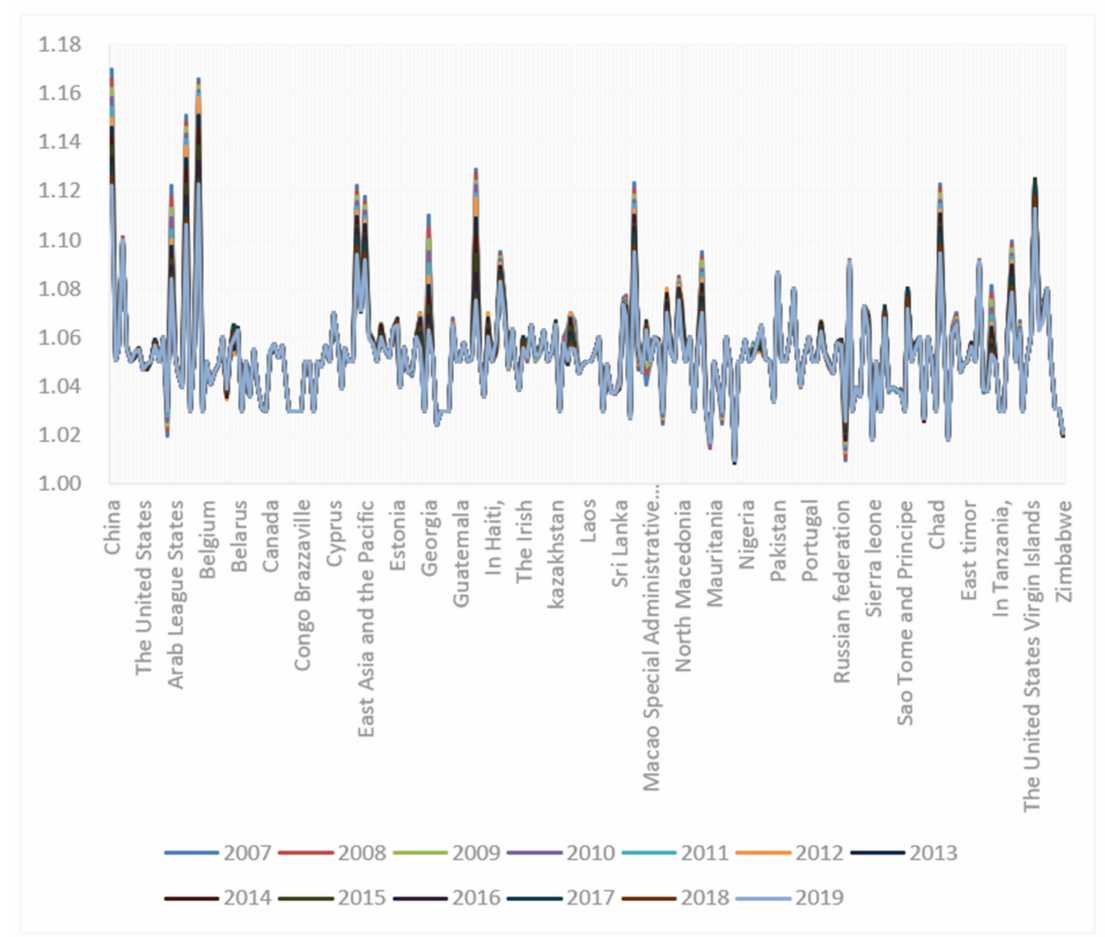
Figure 2. Gender ratio of China’s population at birth, 1972–2019 (female = 100) [9].